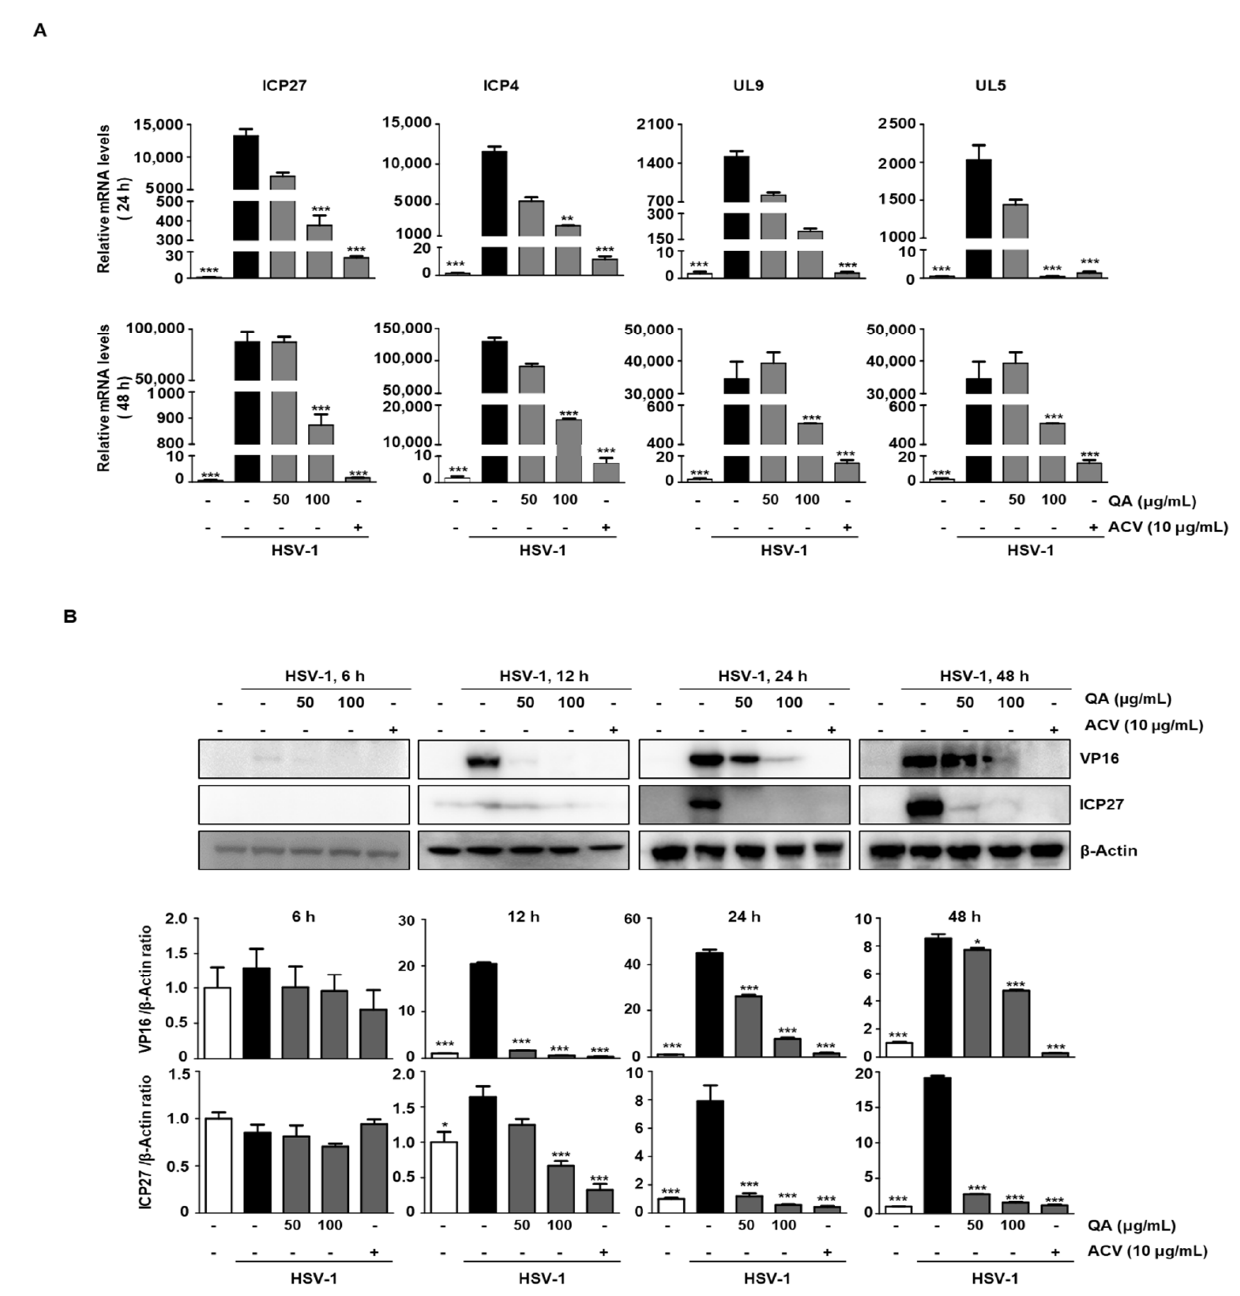
Figure 2. QA exhibits antiviral effects upon infection by HSV-1 in Vero cells. QA reduced mRNA and protein levels of HSV-1-related genes. Vero cells were infected with the HSV-1 strain (MOI = 0.01) for 2 h and then treated with QA at 50 and 100 µg/mL for various times. ( A ) Total RNA was then extracted, and the expression of genes involved in HSV-1 infection was measured by real-time PCR. GAPDH was used as an internal control. ( B ) Expression of genes involved in HSV-1 infection was measured by western blot analysis. β -Actin was used to confirm equal sample loading. The data are representative of three independent experiments and quantified as mean values ± SEM. One-way ANOVA with Tukey’s post hoc test; *** p < 0.001, compared with the HSV-1 treatment.